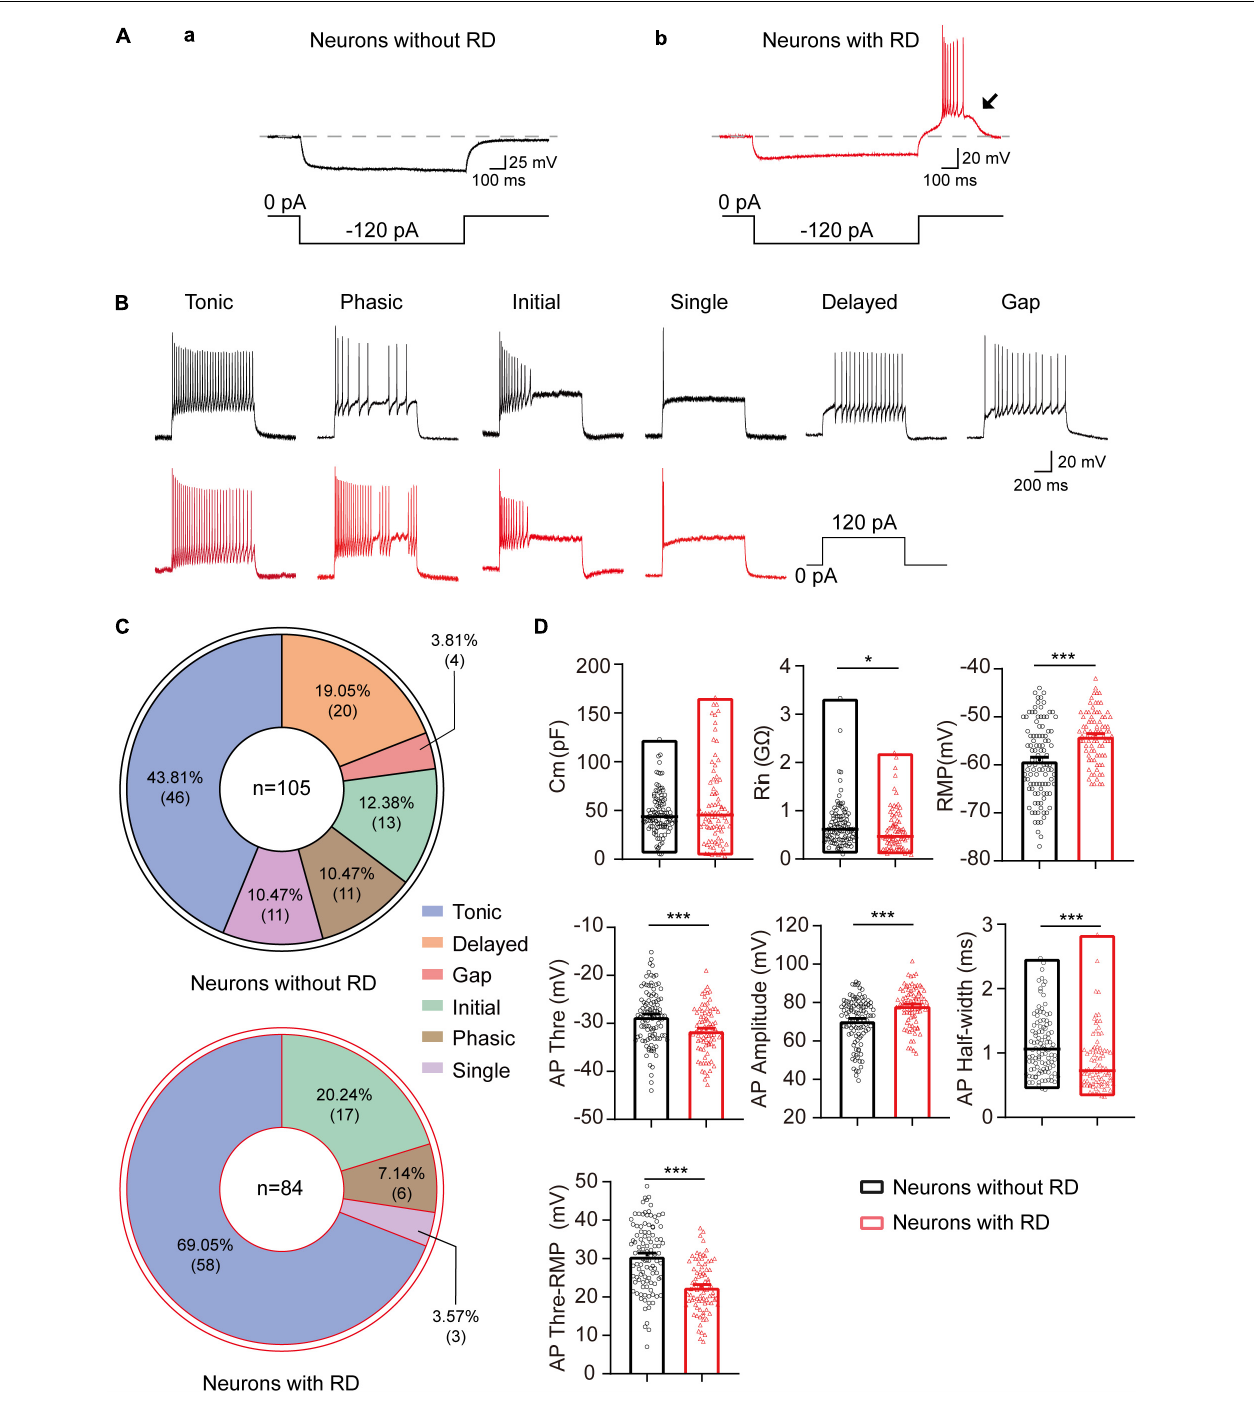
FIGURE 1 | Electrophysiological properties of SG neurons with or without RD from rats. (A) SG neurons without (a) or with RD (b) were classified by a hyperpolarizing current pulse ( − 120 pA, 1 s). The black arrow indicates the presence of RD. (B) Representative traces showing typical firing patterns recorded from SG neurons without (black) or with RD (red). (C) Pie graphs showing the proportion of the different firing patterns in SG neurons lacking RD and those expressing RD. In total, 105 and 84 cells were recorded in each group, respectively. (D) Summary of the passive and active membrane properties of RD-expressing SG neurons (red) and those lacking RD (black). RD, rebound depolarization; Cm, membrane capacitance; Rin, input resistance; RMP, resting membrane potential; AP, action potential. * p < 0.05, *** p < 0.001.